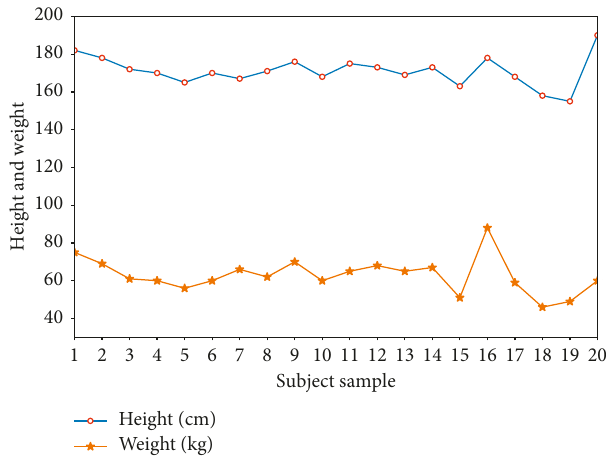
Figure 1: Information about volunteers participating in this experiment.